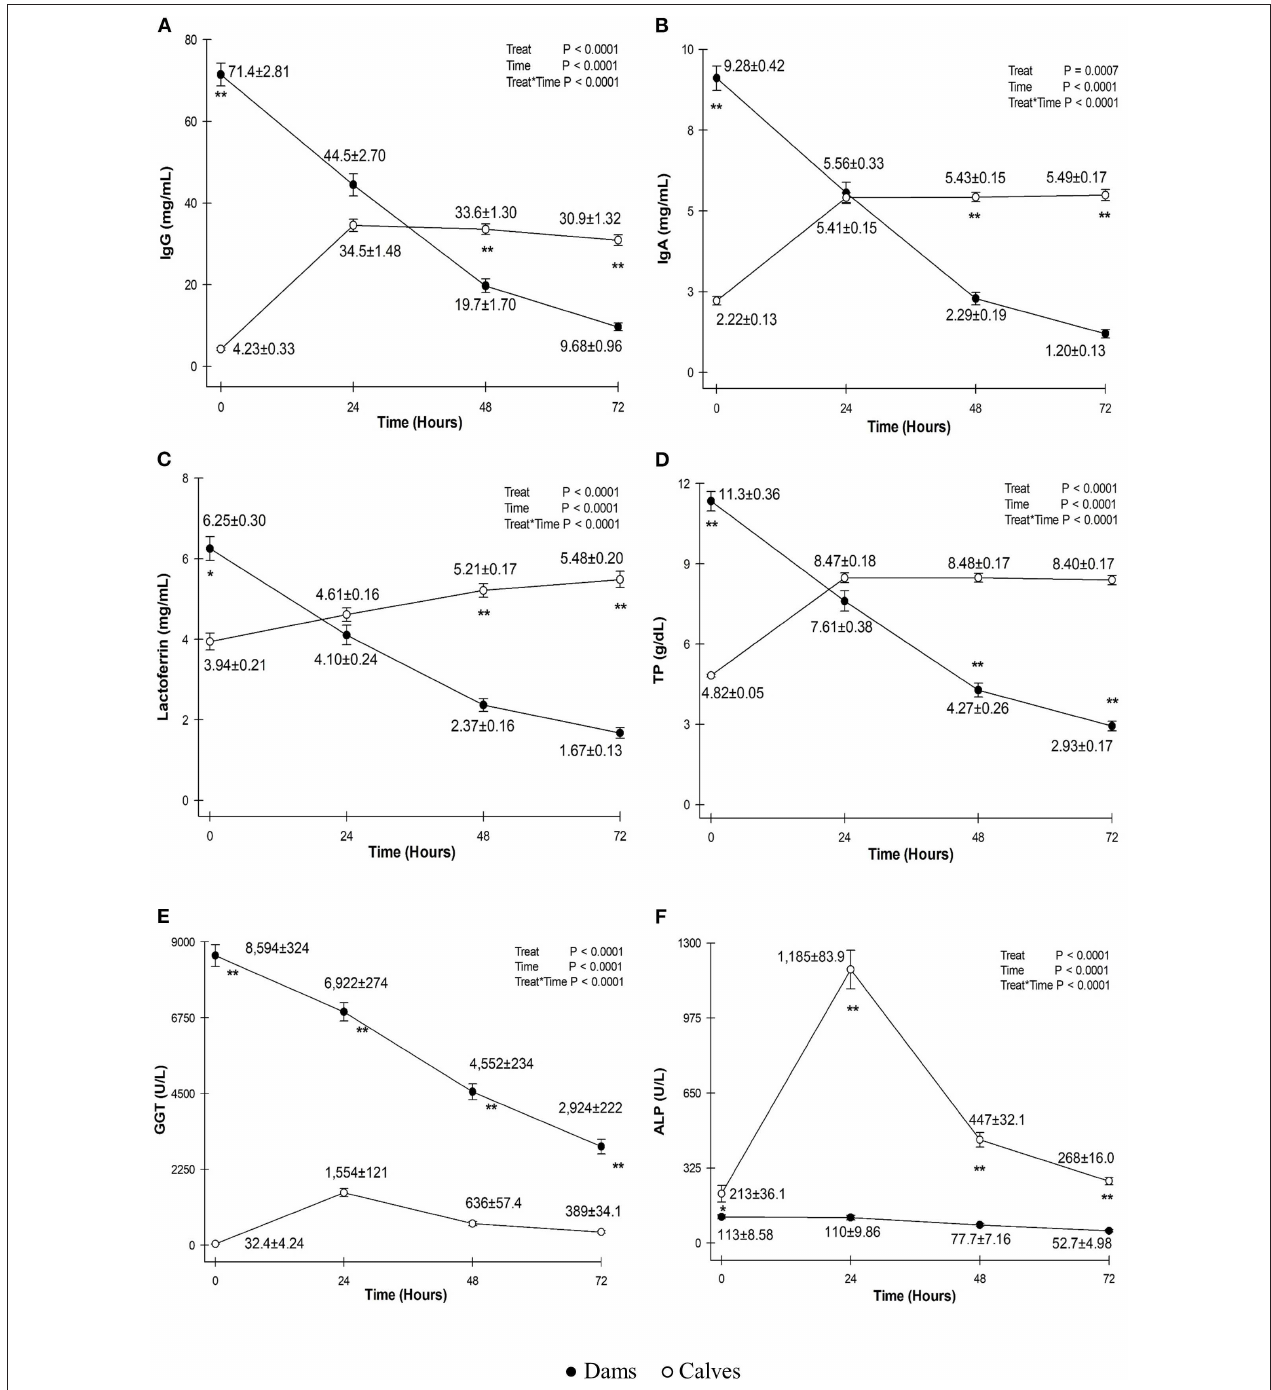
FIGURE 1 | Mean ± standard deviation of serum concentrations of immunoglobulin G (IgG) (A) , IgA (B) , lactoferrin (C) , total protein (TP) (D) and serum activities of gammaglutamyltransferase (GGT) (E) and alkaline phosphatase (ALP) (F) in the colostrum of dams (black circles) and serum of calves (white circles) before colostrum intake and at 0, 24, 48, and 72 h. *P < 0.01; **P < 0.0001.